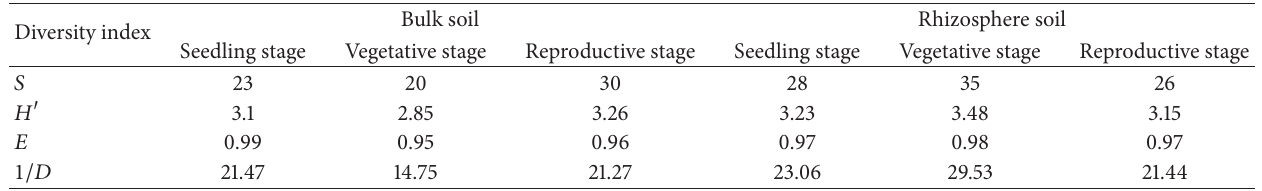
Table 3: Diversity indices associated with the fungal flora present in the rhizosphere and bulk soil samples of continuously monocropped chrysanthemum.